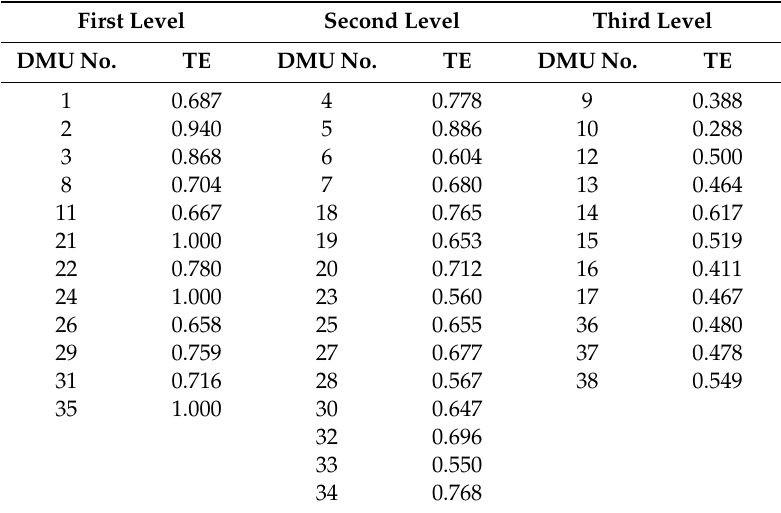
Table 4. Levels of decision-making units (DMUs).